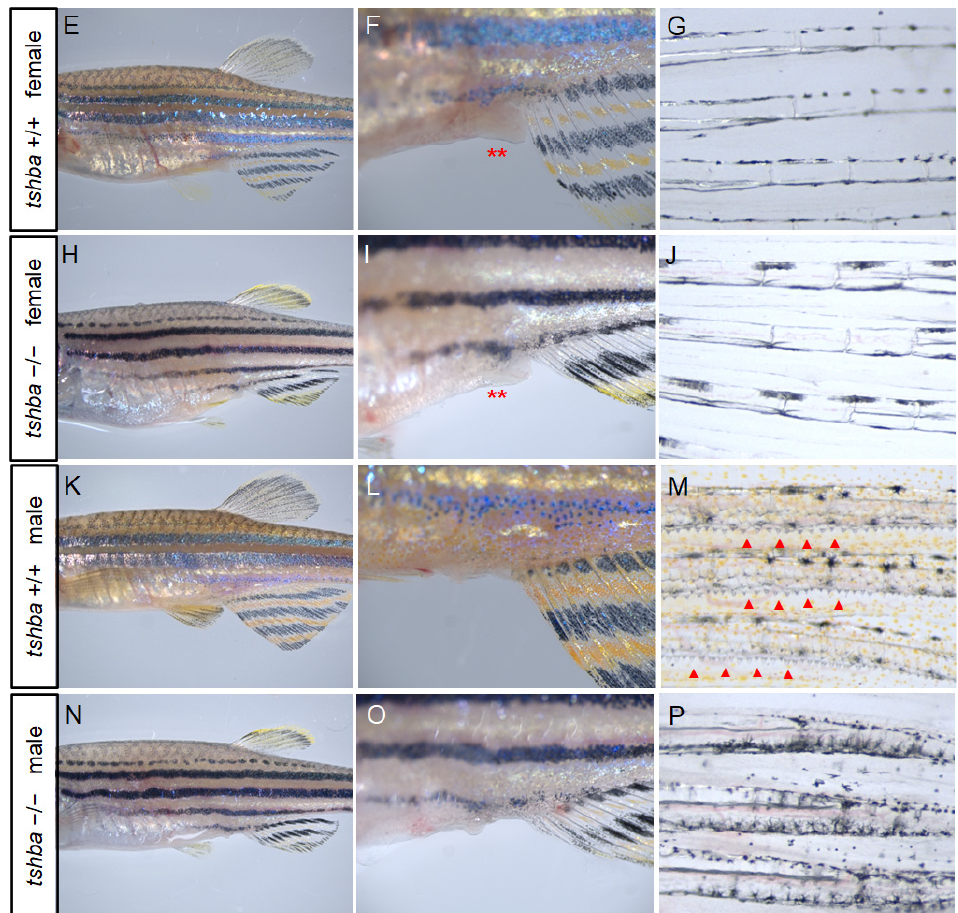
Figure 5. Changes in secondary sex characteristics in tshba mutant zebrafish. ( A , B ) Representative histological sections of ovaries from wild-type zebrafish at 4 mpf ( A ) and from tshba mutant zebrafish at 8 mpf ( B ) by H&E staining. ( C , D ) Representative histological sections of testes from wild-type zebrafish at 4 mpf ( C ) and from tshba mutant zebrafish at 8 mpf ( D ) by H&E staining. ( E , H , K , N ) Gross morphology of wild-type female fish at 4 mpf ( E ), tshba mutant female fish at 8 mpf ( H ), wild-type male fish at 4 mpf ( K ), and tshba mutant male fish at 8 mpf ( N ). ( F , I ) Representative female vent in wild-type ( F ) and tshba mutant ( I ) fish. Red asterisks indicate the vent anterior to the anal fin. ( L , O ) Representative male vent in the wild-type ( L ) and tshba mutant ( O ) fish. ( G , J , M , P ) Pectoral fins of wild-type female fish ( G ), tshba mutant female fish ( J ), wild-type male fish ( M ), and tshba mutant male fish ( P ) are shown. Representative breeding tubercles (BTs) were seen in wild-type male fish ( M ). No BTs were seen in tshba mutant male fish ( L ). Red arrowheads indicate the BTs on the pectoral